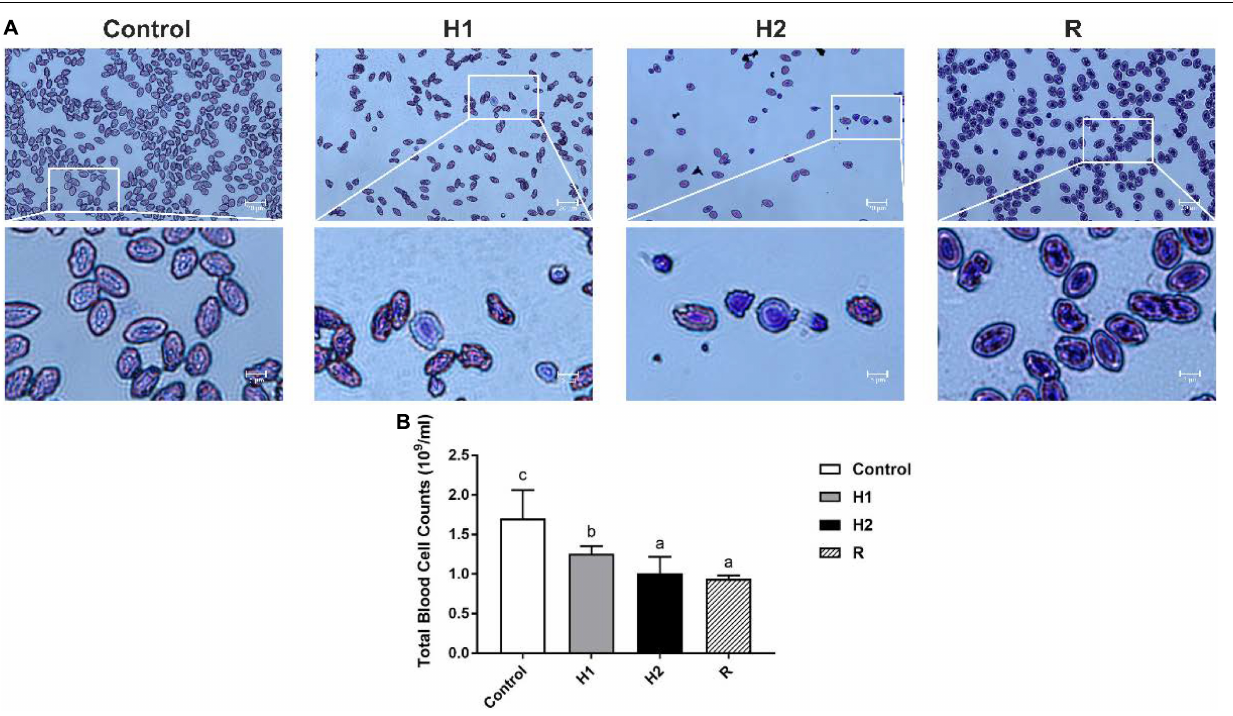
FIGURE 1 | Effects of hypoxia on (A) cell morphology and (B) total blood cell count in largemouth bass after hypoxia. Scale bar = 20 µ m (top), 5 µ m (bottom).